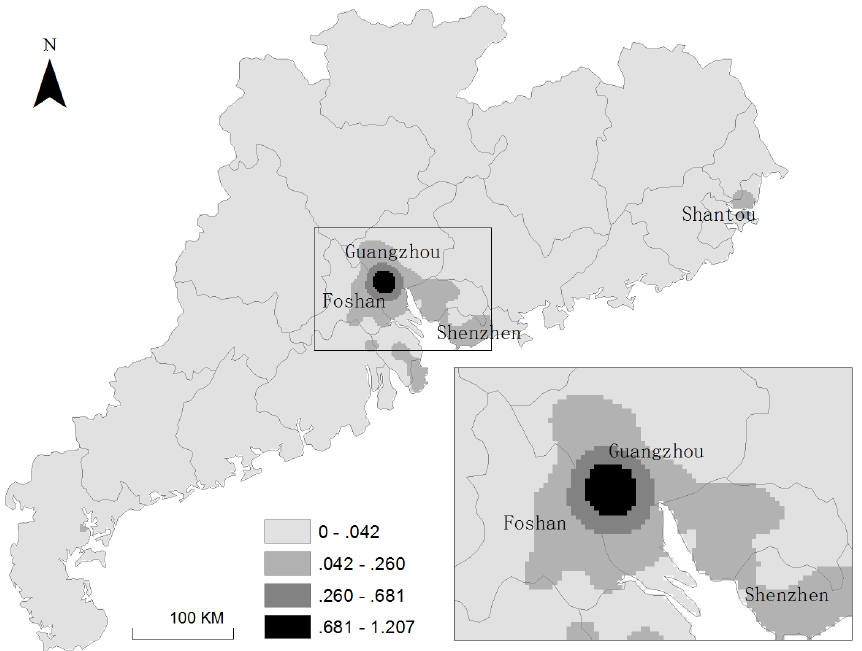
Figure 4. The distribution of posts about dengue fever in Guangdong.